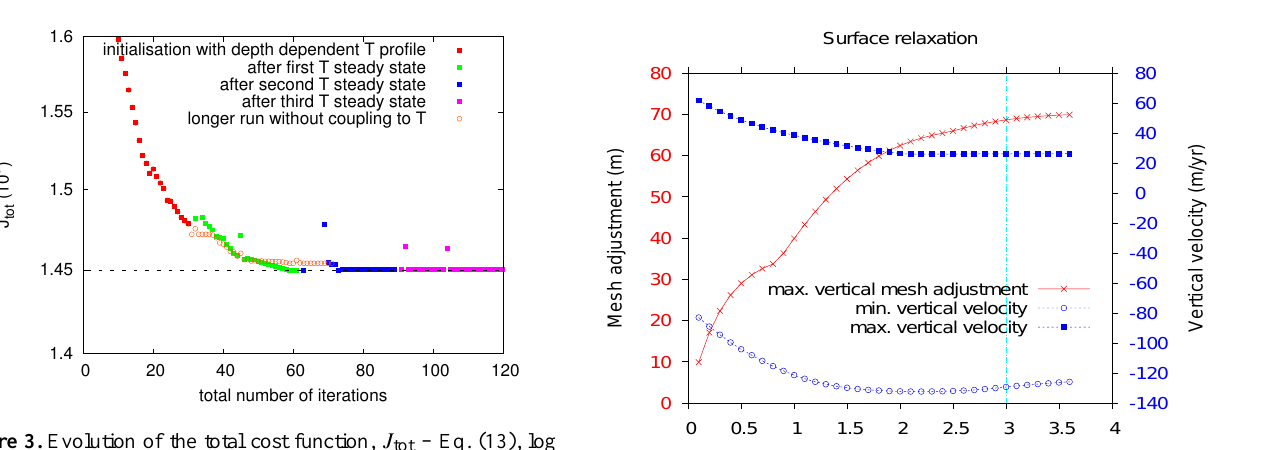
Figure 3. Evolution of the total cost function, J tot – Eq. (13), log scale, scaled by 10 9 – when iterating inverse method and tempera- ture steady-state calculation (1995 velocities, simulation beta95T ). The graph is cut at 1 . 6 × 10 9 for better visibility, higher values in the first iterations are thus not visible. In orange (void circles), the evolution of the cost function when not coupling with temperature is shown.